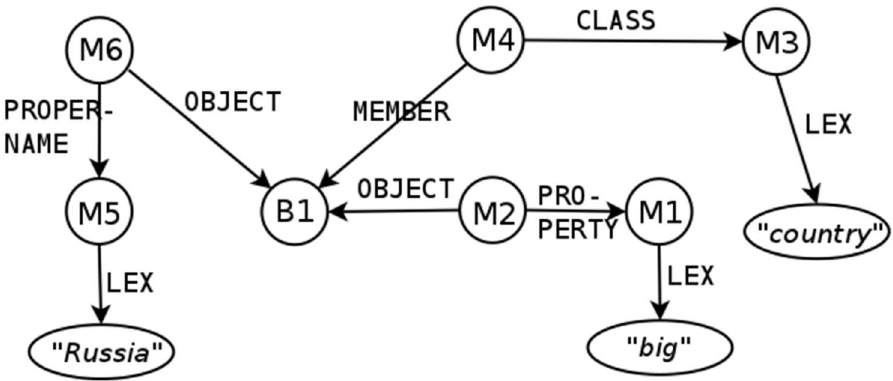
Figure 1. Simple semantic network representing the belief that Russia is a big